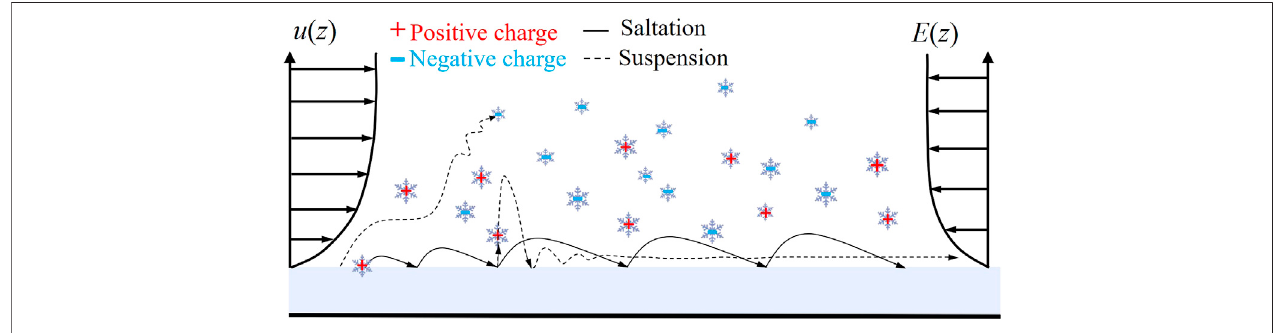
FIGURE 1 | Schematic diagram of a saltation snow fl ake in the wind fi eld and electric fi